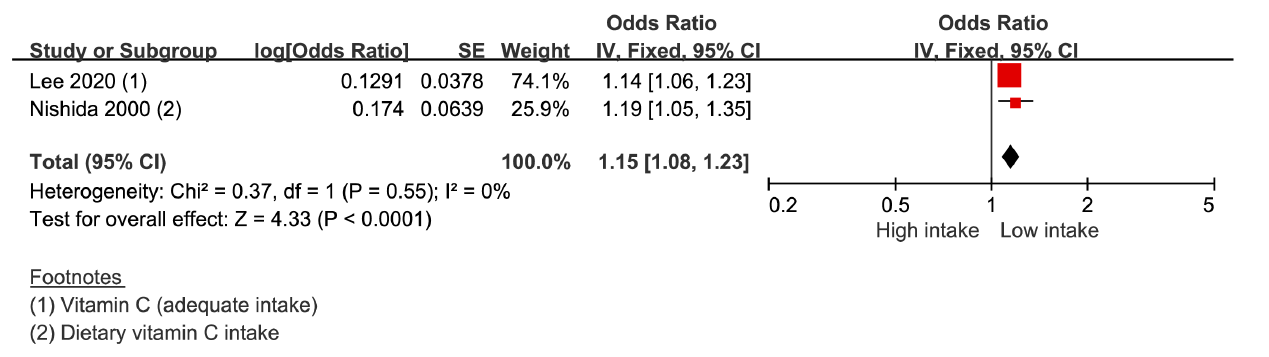
Figure 5. Risk of periodontal disease with vitamin C intake [31,32]. -red color: weight for overall effect; -black color: 95% confidence interval